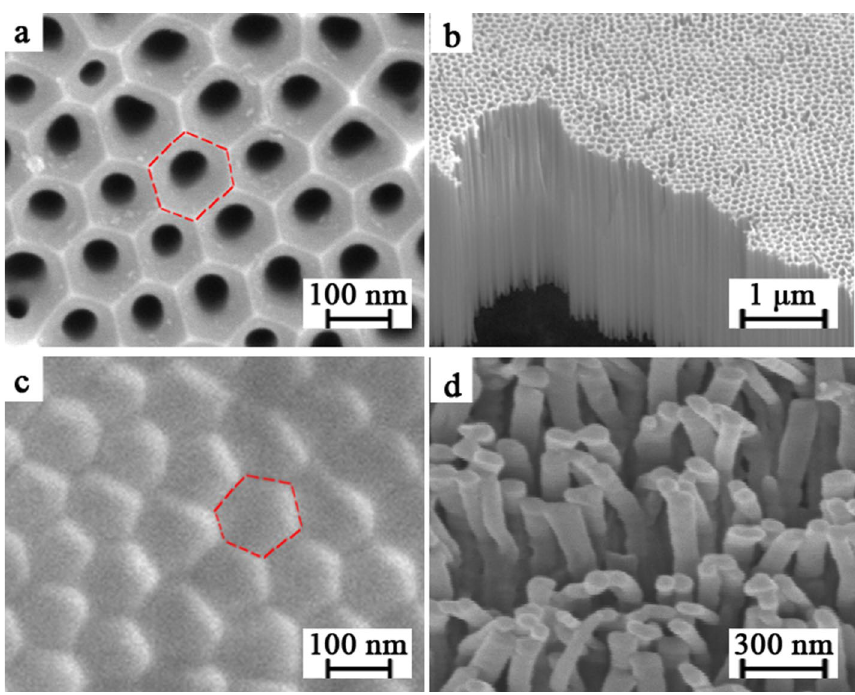
Figure 2. SEM images of samples. ( a ) the surface of AAO membrane before the pore-widening, ( b ) free standing AAO membrane, ( c ) the surface of IPS polymeric for a short duration (3 min) of thermal NIL, and ( d ) the IPS polymeric nanowires for a long duration (40 min) of thermal